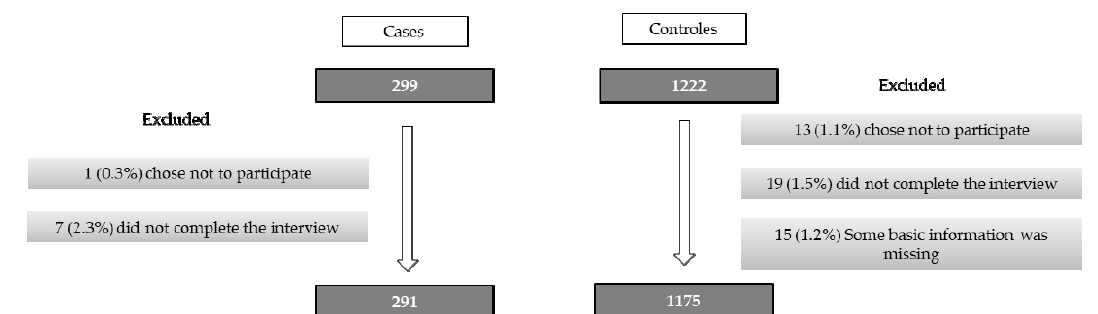
Figure 1. Flow diagram of the women included in the study and analyses.